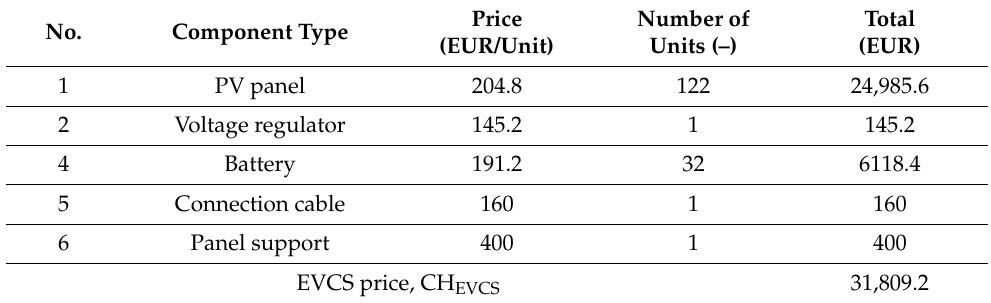
Table 5. Estimation of the investment cost.